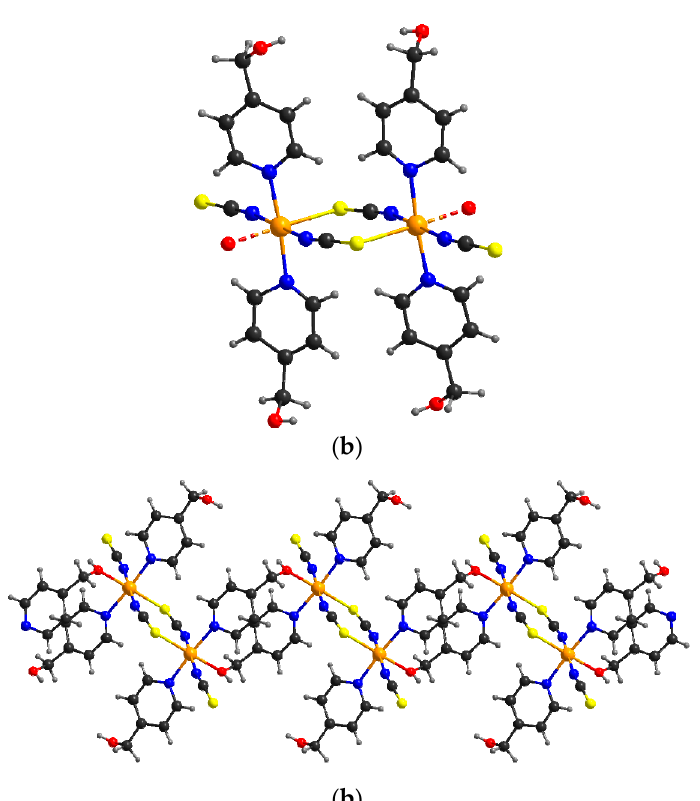
Figure 5. Crystal structure of 5 with view of the dimer ( a ) and the chain ( b ).